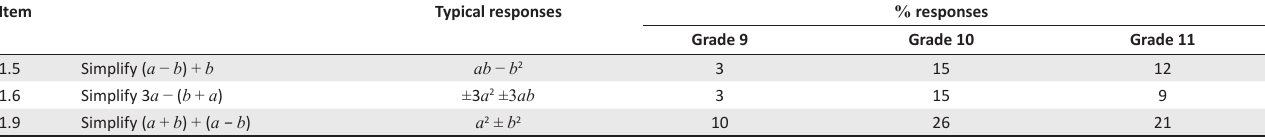
TABLE 5: Percentage of incorrect responses involving distributive law. Item